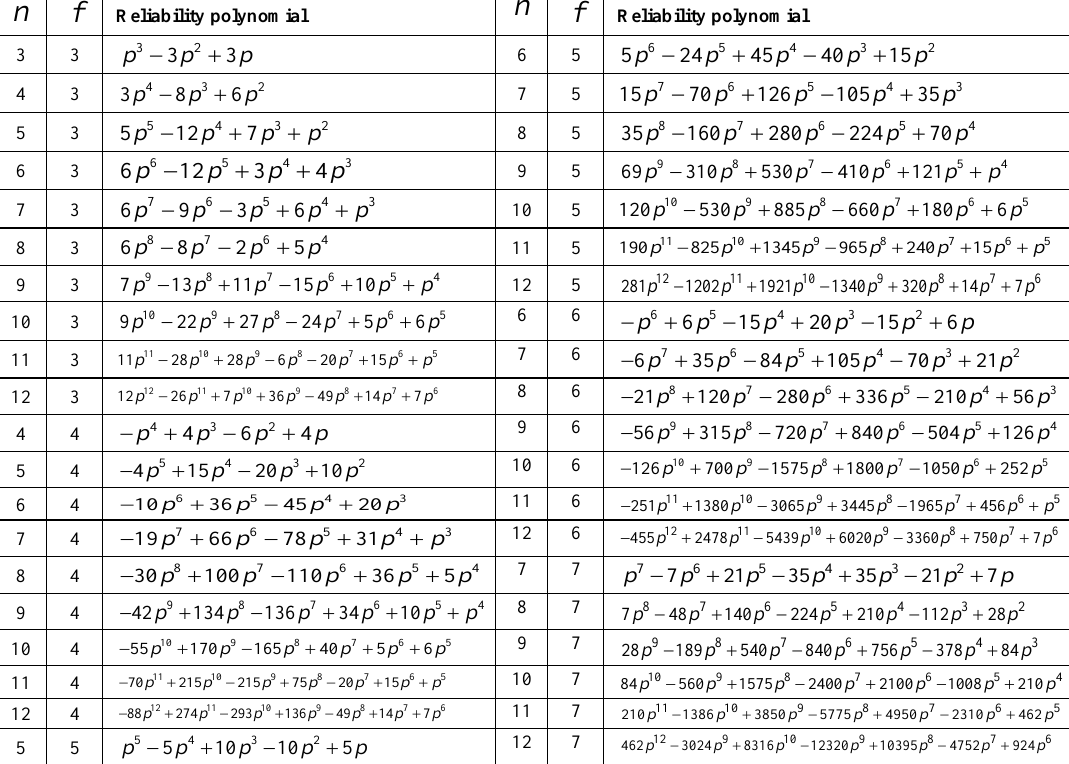
Table 1. Reliability polynomial of < n , f , 2> systems for different values of n , f